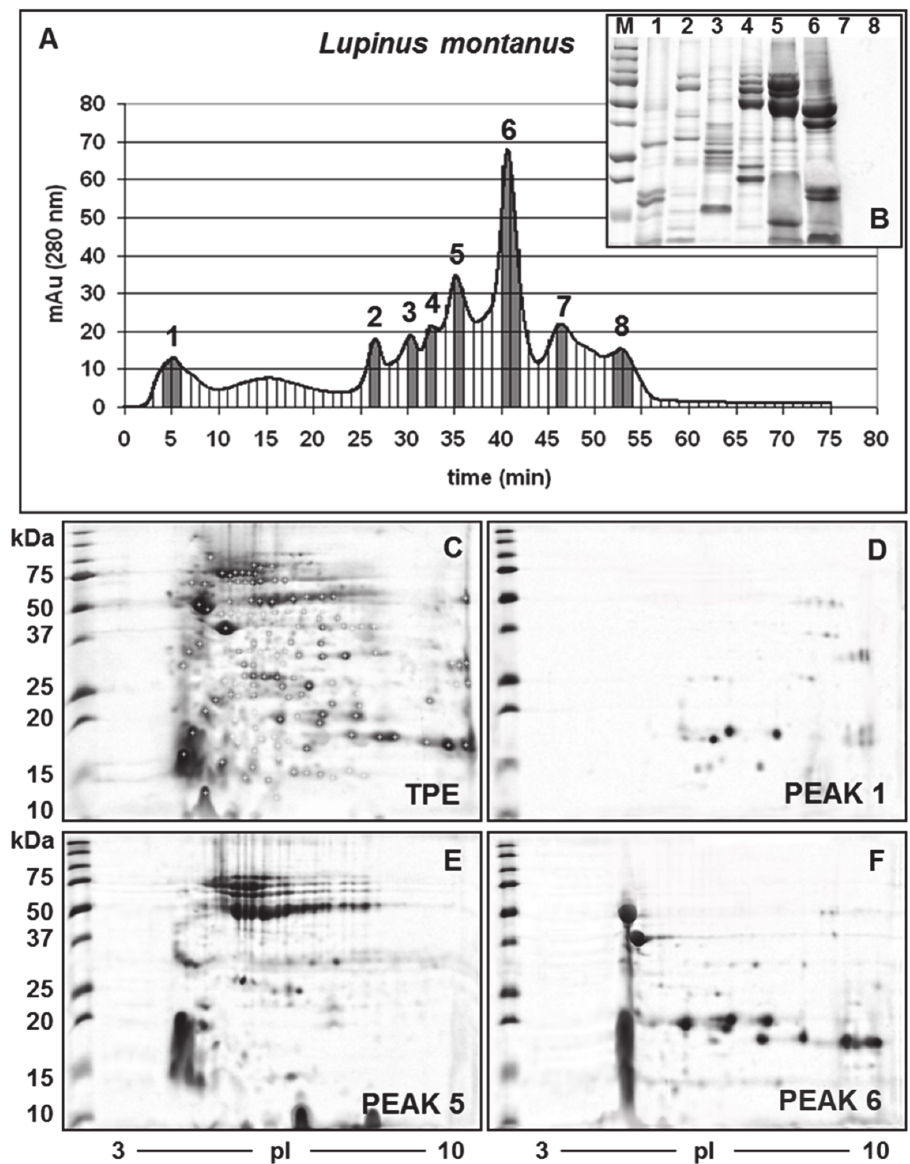
Figure 4. Electrophoretic gels of proteins of L. montanus . ( A ) HPLC chromatogram of the total protein extract (TPE) on a Mono Q column. ( B ) SDS-PAGE of the preparative HPLC collected fractions. ( C ) Proteome reference map of reduced TPE, where in total 134 spots were detected. ( D ) Two ‐ di ‐ mensional map of purified γ‐ conglutin. ( E ) Two ‐ dimensional map of purified β‐ conglutin. ( F ) Two ‐ dimensional map of purified α‐ conglutin. The standard marker (Precision Plus Protein) is indicated in kDa on the left.